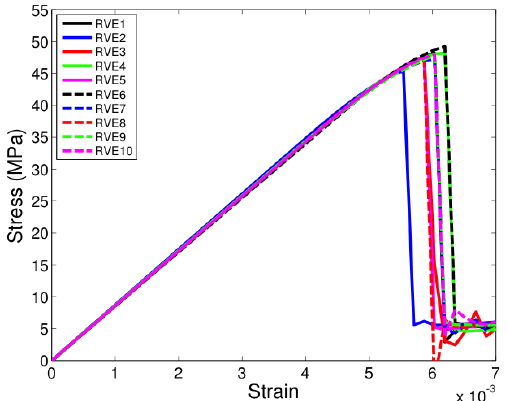
Figure 10. Transverse tensile response of 24-fiber unit cells with V